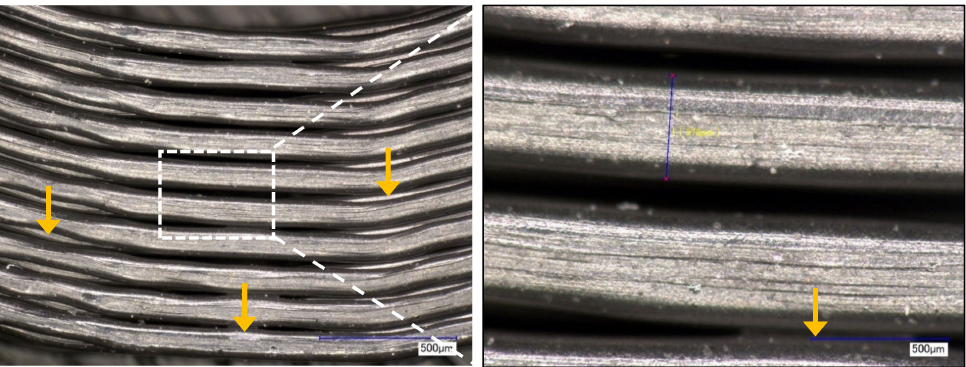
Figure 8. Typical microscopic images of R2 coils at 200 × and 50 × magnifications, representing bonding and contact between different 3D printed patterns distributed at different scales (shown by arrows).